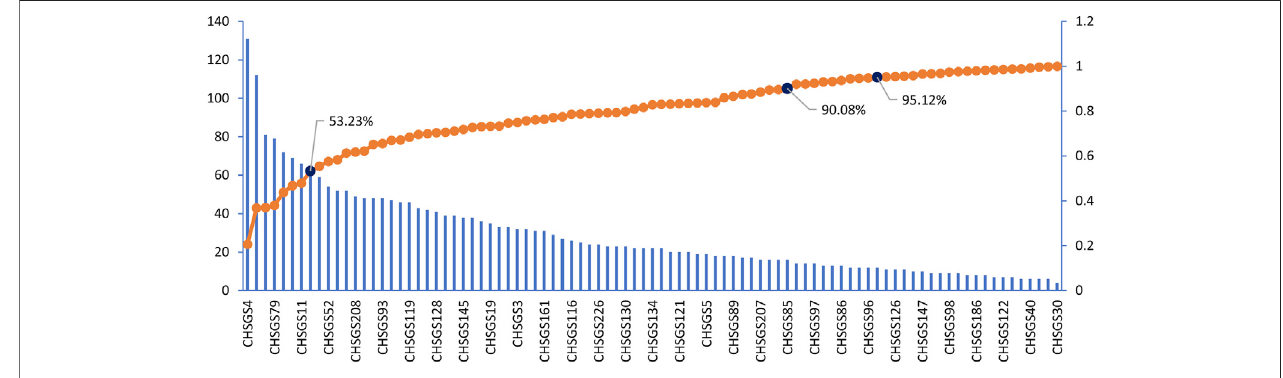
FIGURE 5 | The accumulative CCC of active components in effective intervention